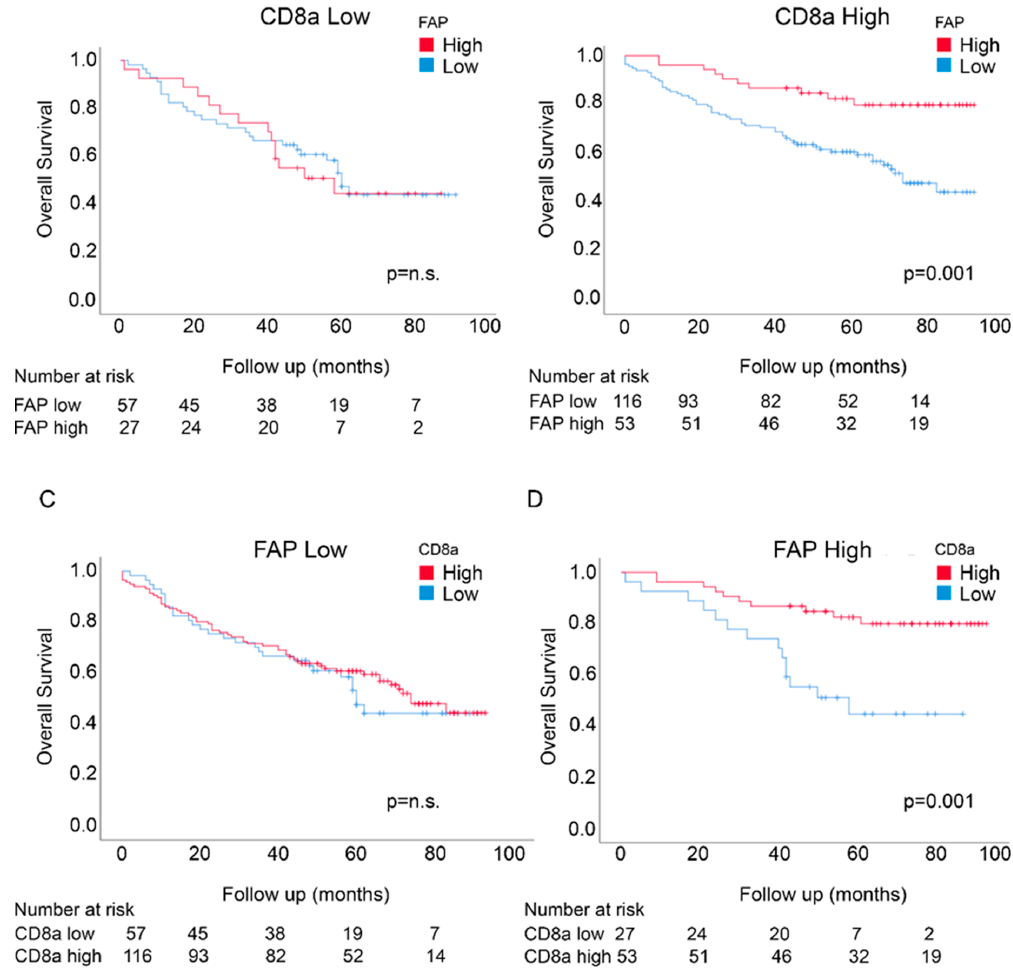
Figure 2. Overall survival in the U-CAN cohort for FAP intensity in patients expressing low levels of CD8a density ( A ) and high levels of CD8a density ( B ) and for CD8a density in patients expressing low levels of FAP intensity ( C ) and high levels of FAP intensity ( D ).